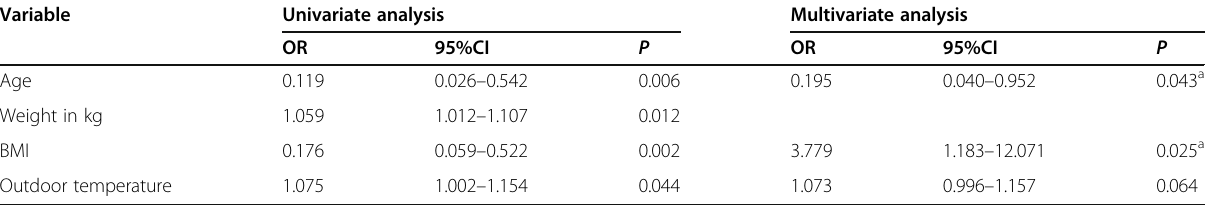
Table 5 Univariate and multivariate logistic regression analysis of the relationship between BAT activation and patient ’ s age, weight, BMI, and outdoor